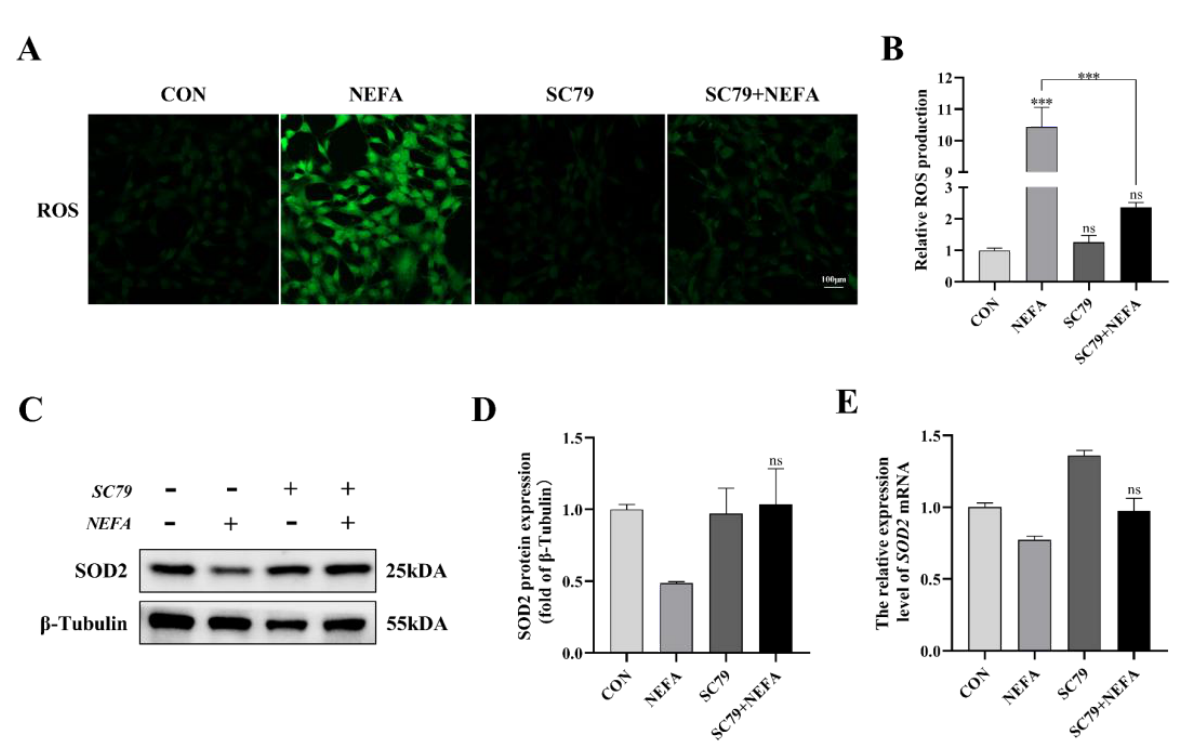
Figure 6. AKT activator SC79 alleviated NEFA − induced ROS and oxidative stress in BGCs. Ex- periments were performed with non − treated, 5 mg/mL SC79, 1.2 mM NEFA, or 5 mg/mL SC79 for 2 h followed by 1.2 mM NEFA supplement for 24 h. ( A , B ) ROS formation was determined by fluorescence microscopy. Green: DCFH − DA, scale bar: 100 µ m. ( C – E ) SOD2 protein and gene expression in BGCs. The quantification of the relative protein levels (performed using Image J) is shown under the band (protein/ β − Tubulin). This experiment was repeated 3 times, and data are expressed as mean ± standard errors of the mean (SEM), *** p < 0.001; ns, not